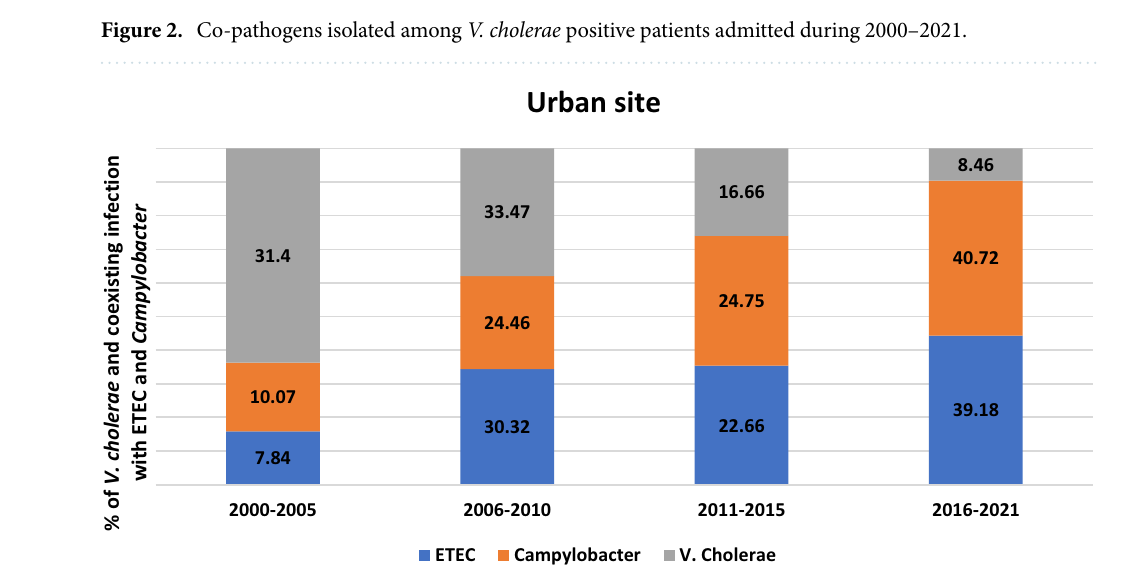
Figure 3. Percentage V. cholerae and co-existing infection with ETEC and Campylobacter in urban